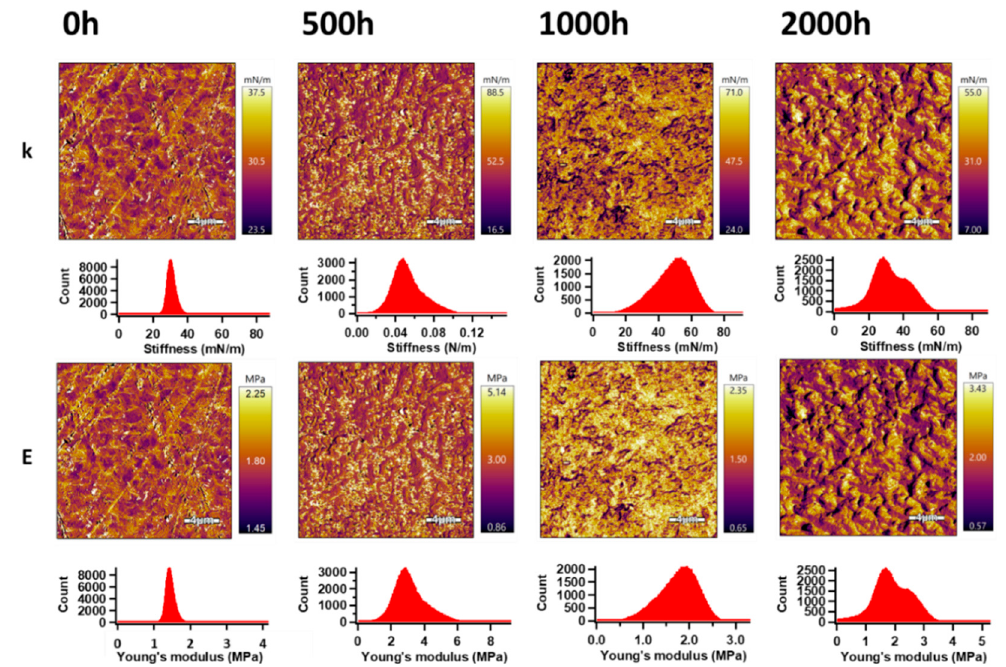
Figure 11. A mplitude modulation–frequency modulation (AM–FM) images (upper) and histograms (lower) of the PHBV samples, before and after the accelerated weathering; k and E represent the stiffness and Young’s modulus, respectively.